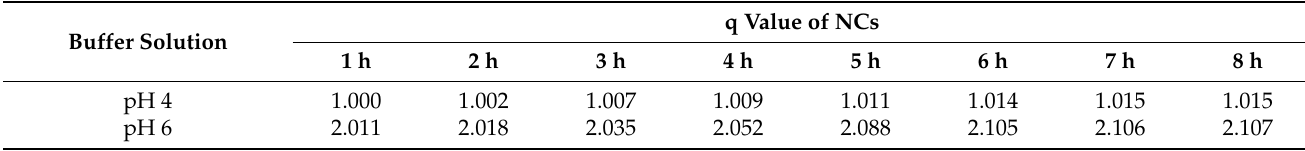
Table 2. The weight swelling ratio (q) of NCs in pH 4 and pH 6